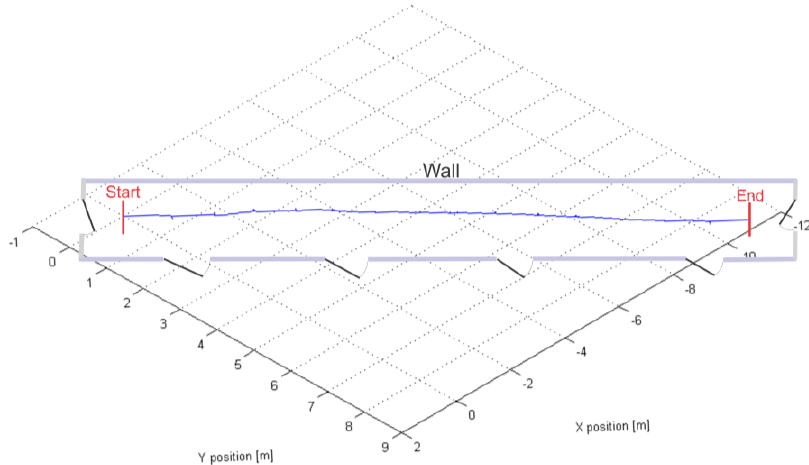
Figure 8. 2D top view graph of the reconstructed experimental slow walk. The path started at the entrance to our Lab and following the wall finished at the other end of the corridor.